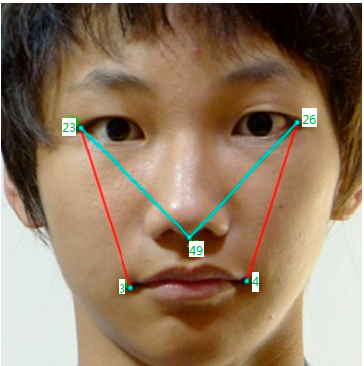
Figure 3. Four reference lines to determine happiness.